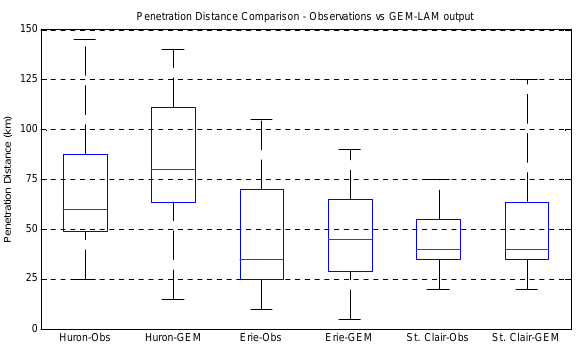
Fig. 7. Box and whiskers diagram comparing observed and GEM-LAM maximum penetration distances at or before 17:00 LT. On each box, the red central mark is the median, the top and bottom of the box are the upper and lower quartiles, respectively, and the whiskers extend to the most extreme data points.